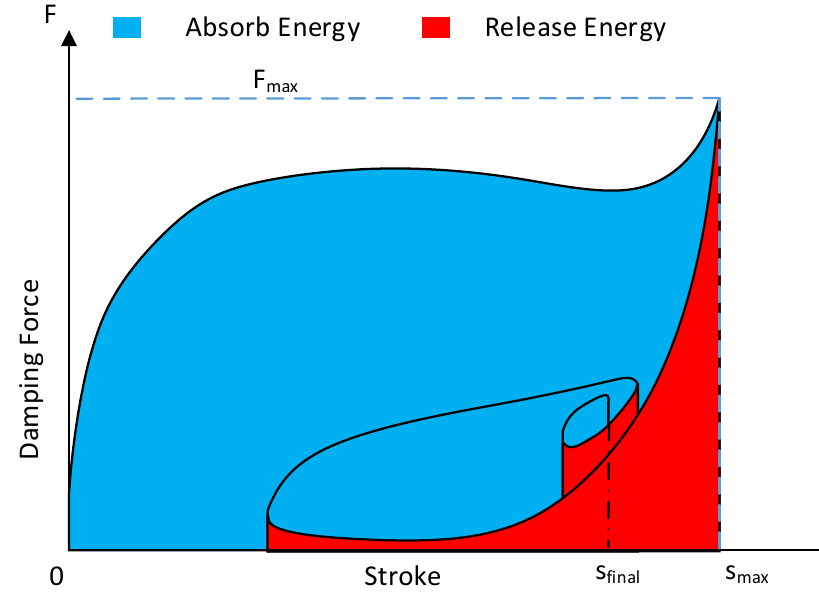
Figure 5. Load–stroke curve.